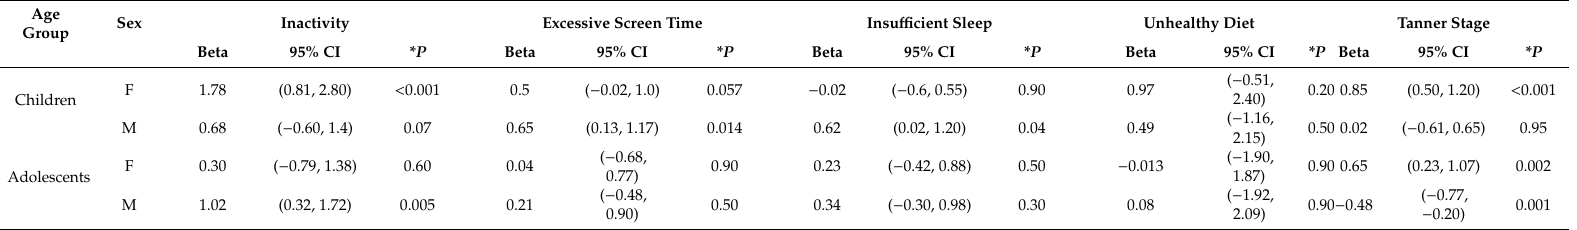
Table 6. Multiple regression analysis of OL components to FMI (kg / m2) stratified for sex and age groups and adjusted for